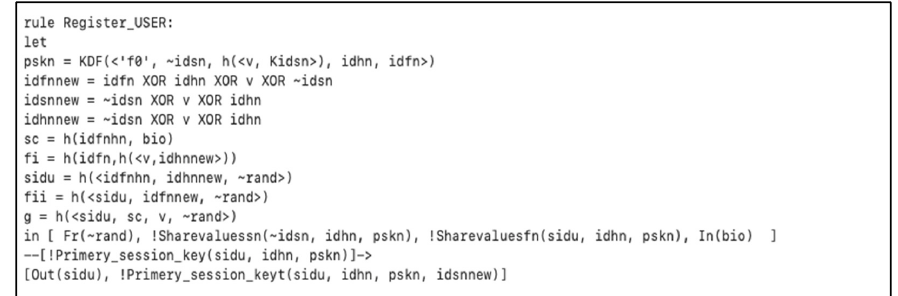
Figure 6. Initialization and registration phase for the user and other nodes.